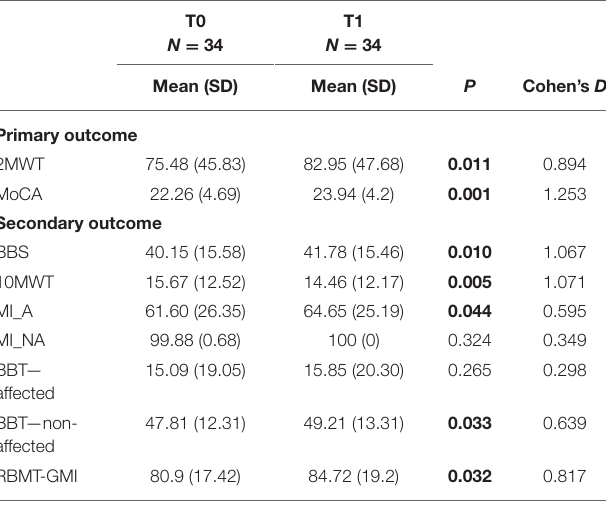
TABLE 2 | Efficiency of the ClinicHEAD approach